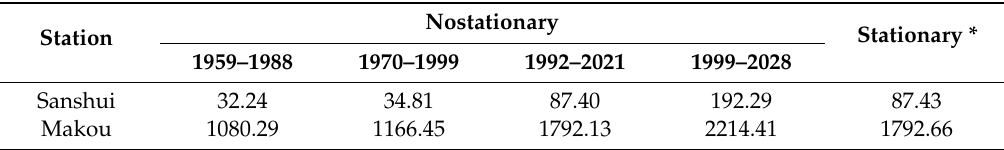
Table 1. 7Q10 for Sanshui station and its corresponding low flow at Makou according to the typical low flow method (m 3